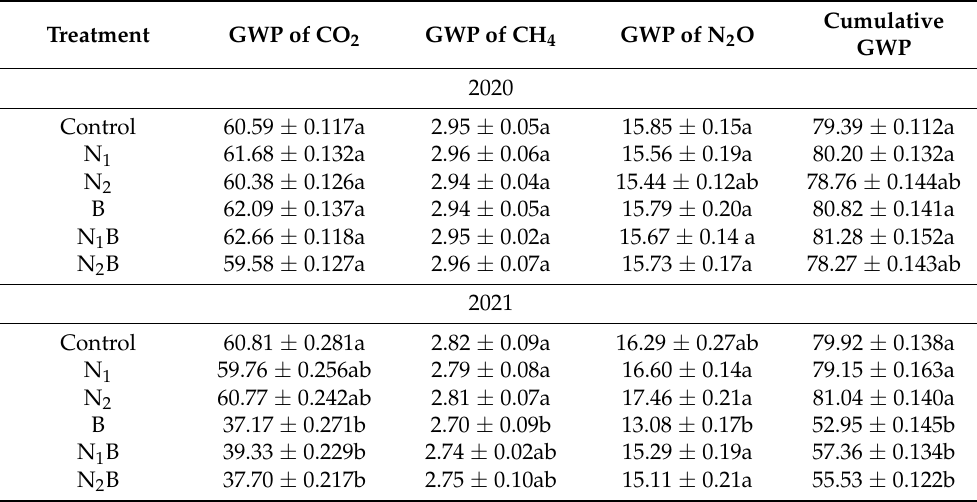
Table 3. Effect of biochar on global warming potential (GWP) (mg ha hr − 1 ) during the years of 2020 and 2021. Treatment GWP of CO 2